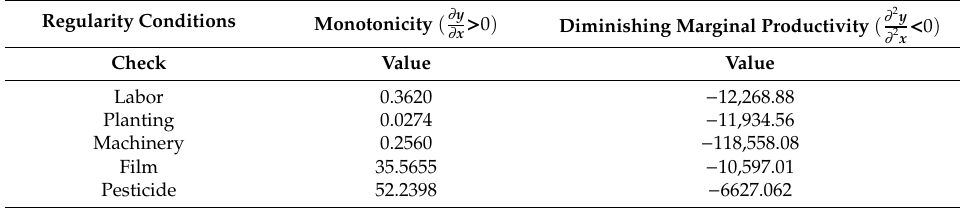
Table 3. First and second derivatives at the point of approximation (sample mean).